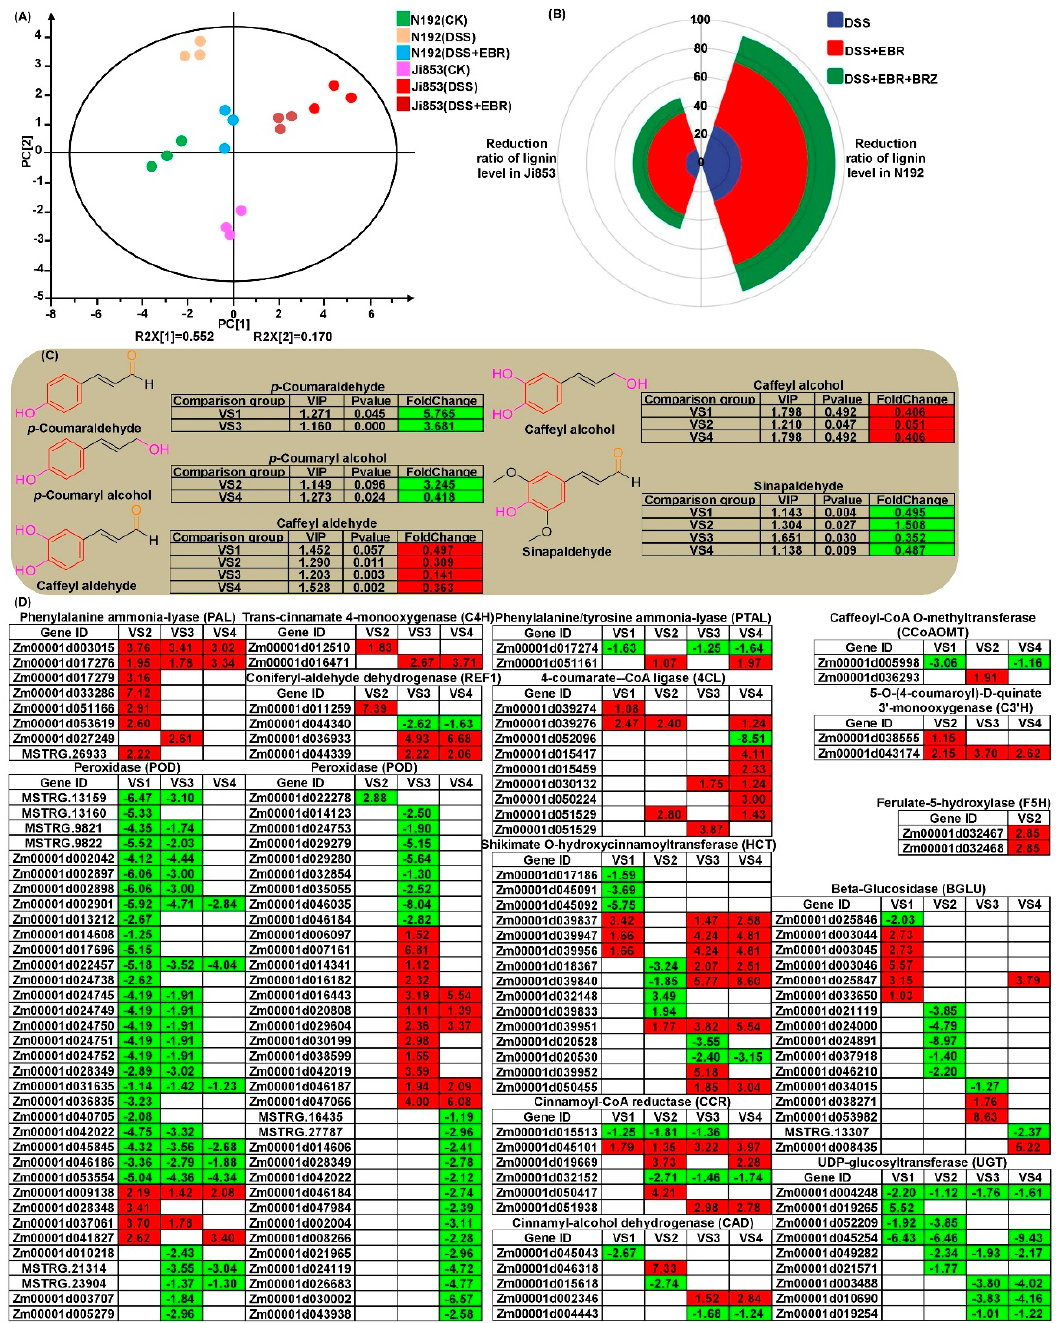
Figure 2. Differentially expressed genes (DEGs) and differentially accumulated metabolites (DAMs) involved in lignin biosynthesis in N192 and Ji853 mesocotyls under CK, DSS, and DSS + EBR conditions. Principle component analysis (PCA) of the lignin metabolites derived from ultra–high–performance liquid chromatography-tandem mass spectrometry (UPLC–MS/MS) ( A ). Polar coordinate graph for reduction ratio of lignin level in N192 and Ji853 mesocotyls under DSS, DSS + EBR, and DSS + EBR + BRZ conditions that compared to CK control ( B ). DAMs were analyzed in all four comparisons [N192 (DSS_VS_CK), VS1], [N192 (DSS + EBR_VS_CK), VS2], [Ji853 (DSS_VS_CK), VS3], and [Ji853 (DSS + EBR_VS_CK), VS4]). The red and green box represented up– and down–accumulated DAMs, and the value in the box was the fold–change of DAMs ( C ). DEGs involved in lignin biosynthesis in four comparisons. The red and green box represented up– and down–regulated DEGs, and the value in the box was the log2 fold-change of DEGs ( D ).